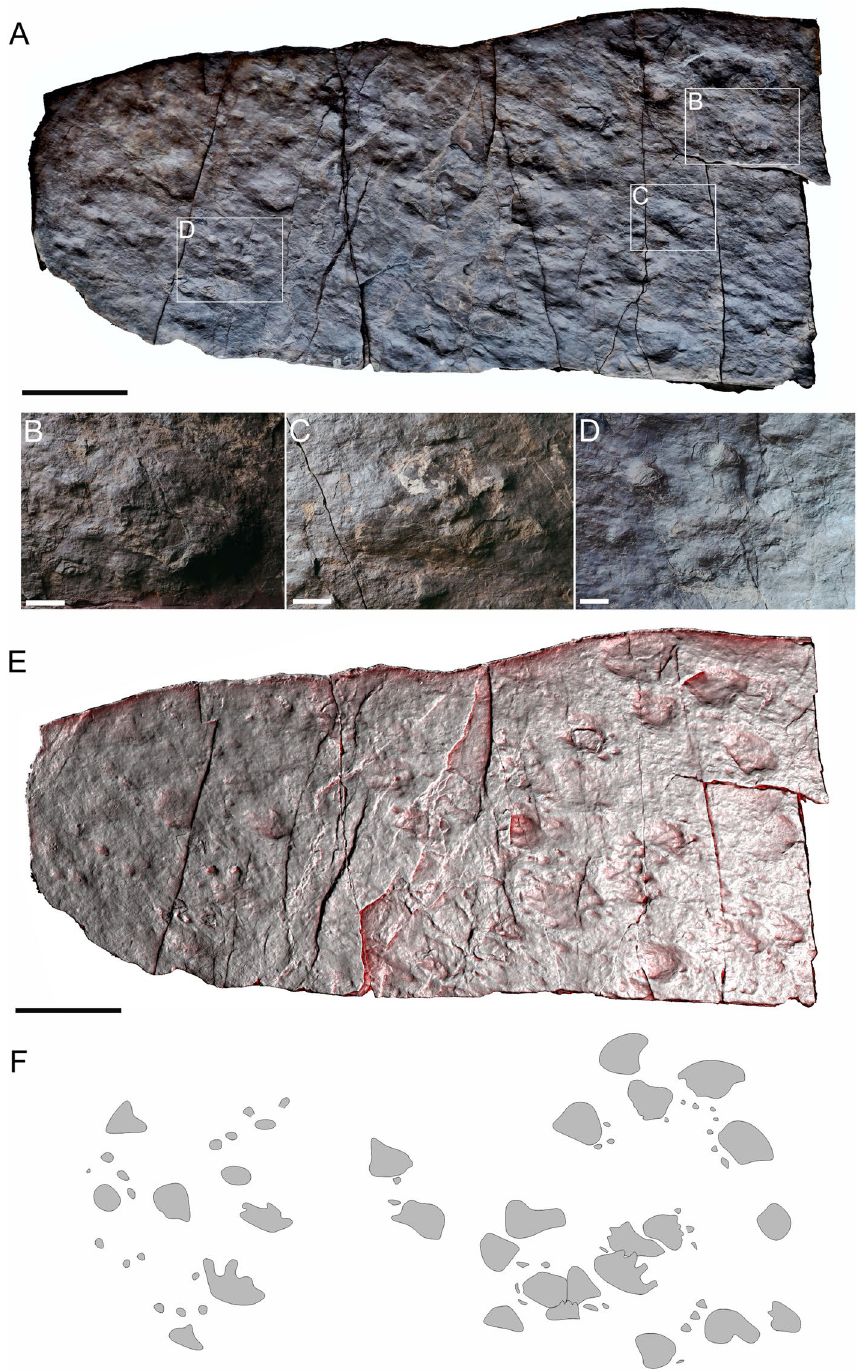
Figure 7. The slab showing ( A ) many incomplete step cycles of MZM Ge 33074 (concave epirelief); ( B , C ) Dimetropus isp. tracks (convex hyporelief); ( D ) indeterminate track resembling Ichniotherium (concave epirelief); and ( E ) image ‐ based modeling and ( F ) outline drawing of the whole slab. Scale bars: ( A , E , F ) 20 cm, ( B – D ) 2